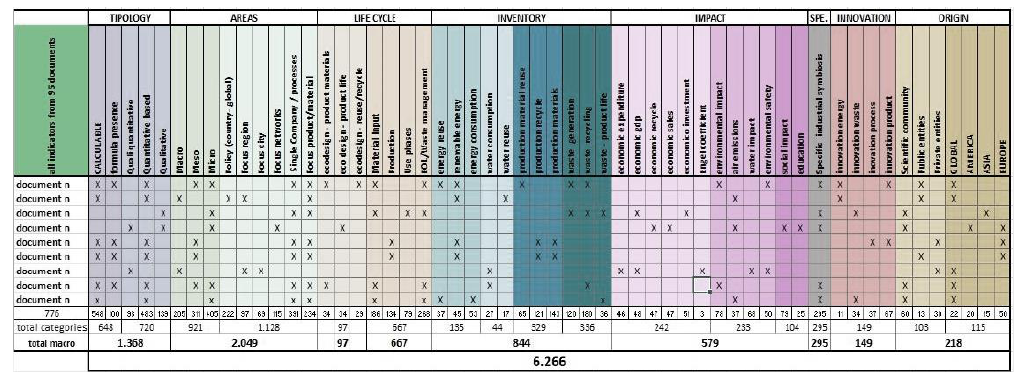
Figure 9: Extrapolation of Indicators Through the Correlation